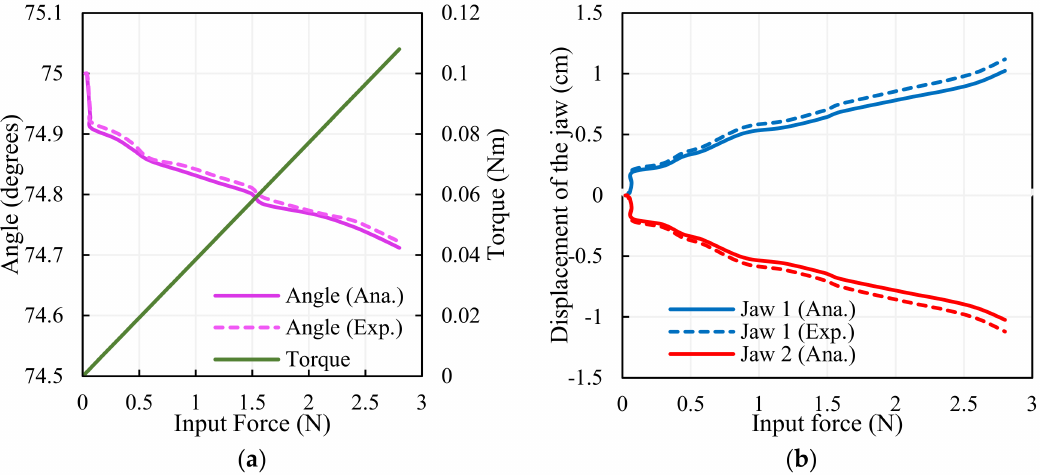
Figure 7. Characteristics of the gripper: ( a ) angle–torque of the gripper. ( b ) Displacement of the gripper